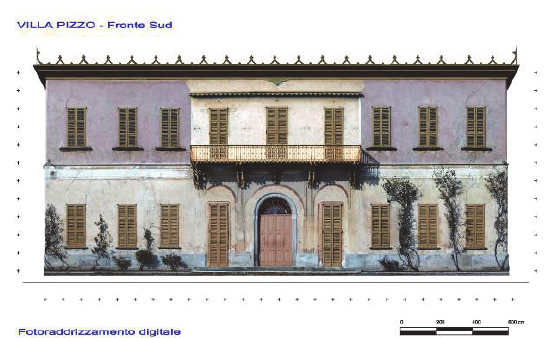
Figure 3 Villa Pizzo (Co) 2001. Rectified image at 1:50 scale. Created using a film camera reflex Canon Eos 500 with 50 mm lens and 100 ASA Kodak colour film. 21 photos were used to cover the front, with an overlap of the 60 percent both transversally and longitudinally. The photographic images are acquired with scanner to the resolution of 200 dpi. (Studio Campanella